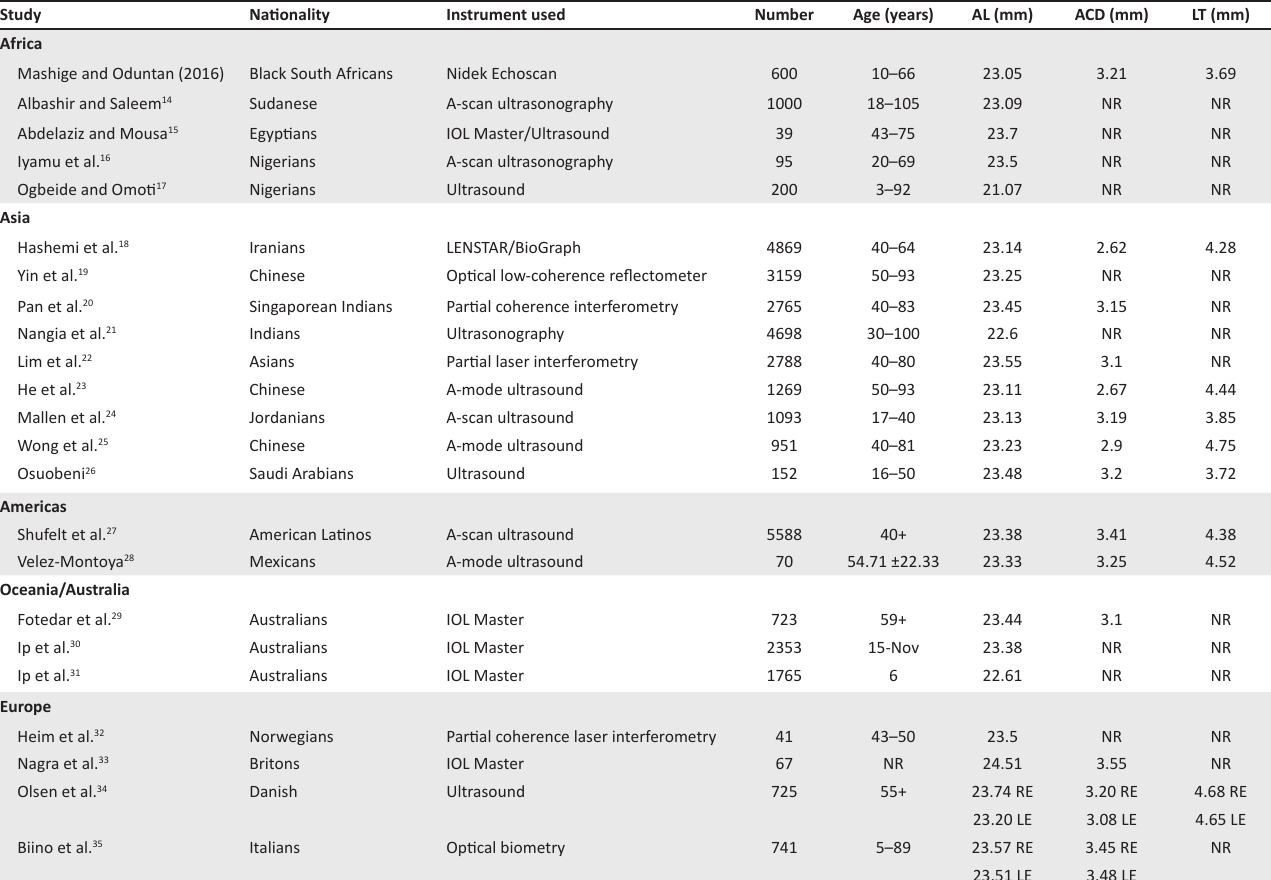
TABLE 5: Axial length, anterior chamber depth and lens thickness reported in subjects of different races and ethnicities as compared with findings of our study (third row below).